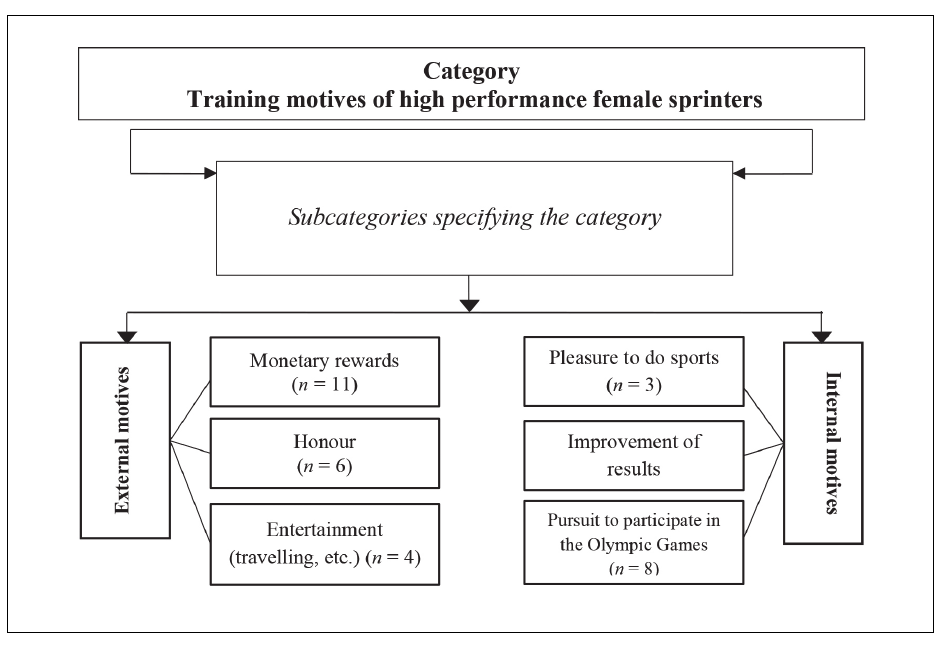
Figure 3. Strong and weak features of high perfor- mance female sprinters’ training system